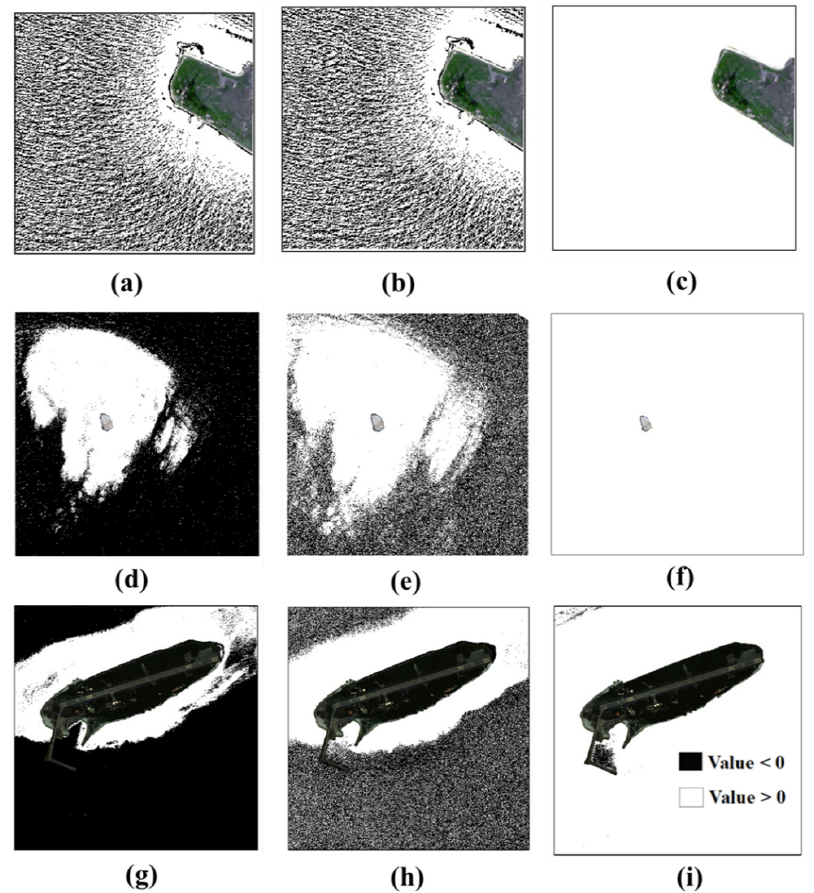
Figure 5. Red band binary images of Dongdao Island, Tiexian Jiao and Taiping Island after sun glint correction. ( a – c ) Hedley’s method, Goodman’s method and ND-SGC method in Dongdao Island, respectively; ( d – f ) Hedley’s method, Goodman’s method and ND-SGC method in Tiexian Jiao, respectively; ( g – i ) Hedley’s method, Goodman’s method and ND-SGC method in Taiping Island,